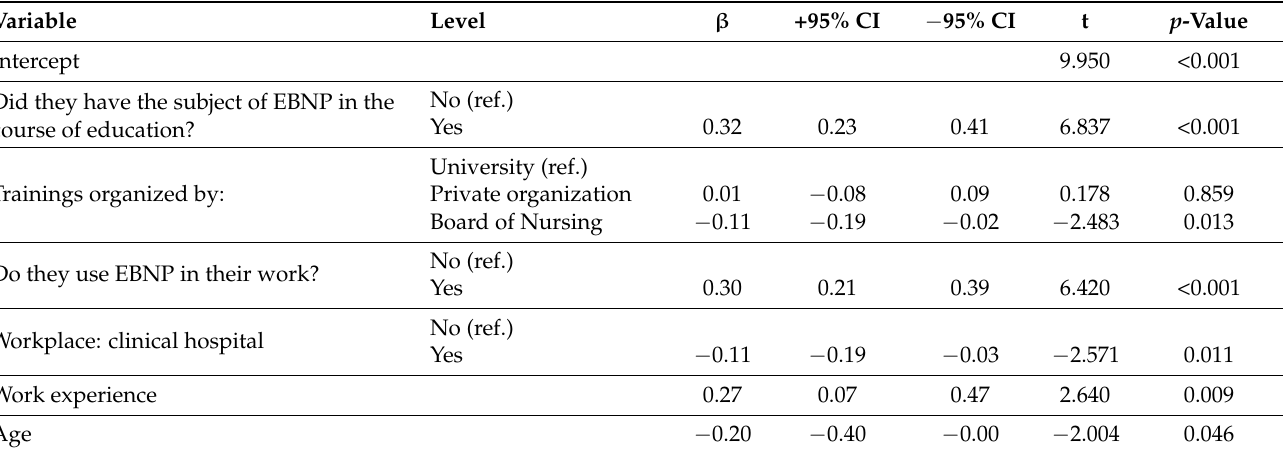
Table 9. Regression analysis for the stepwise model for the subscale ‘Attitude towards expanding one’s competence in EBNP’.